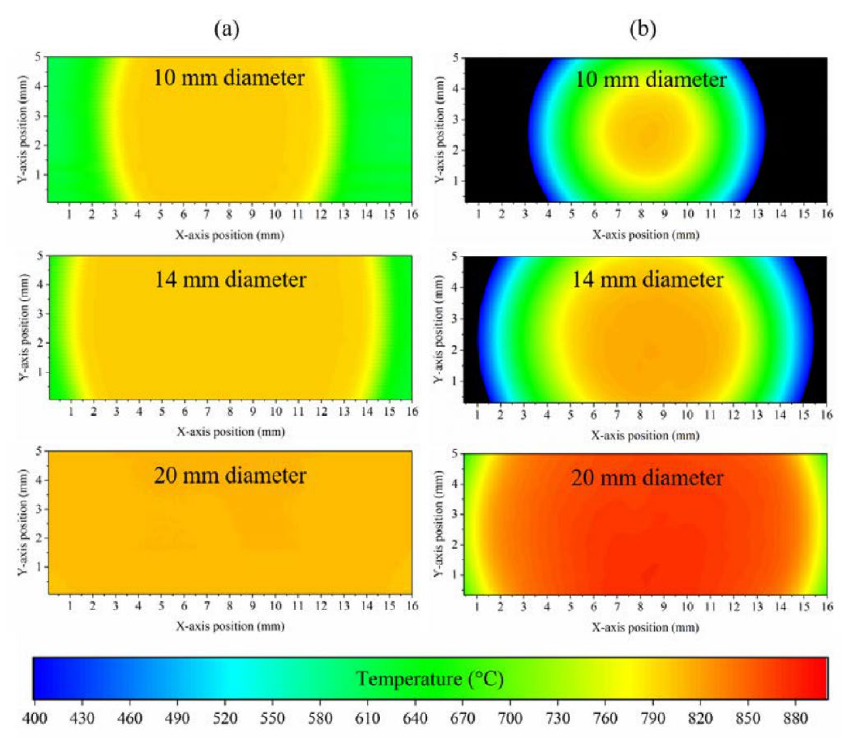
Figure 5. SSE analysis for ( a ) Si APD and ( b ) bolometer camera imagers with increasing target aperture size at a furnace temperature of 800 °C. Reproduced from [42] under license CC BY 4.0.